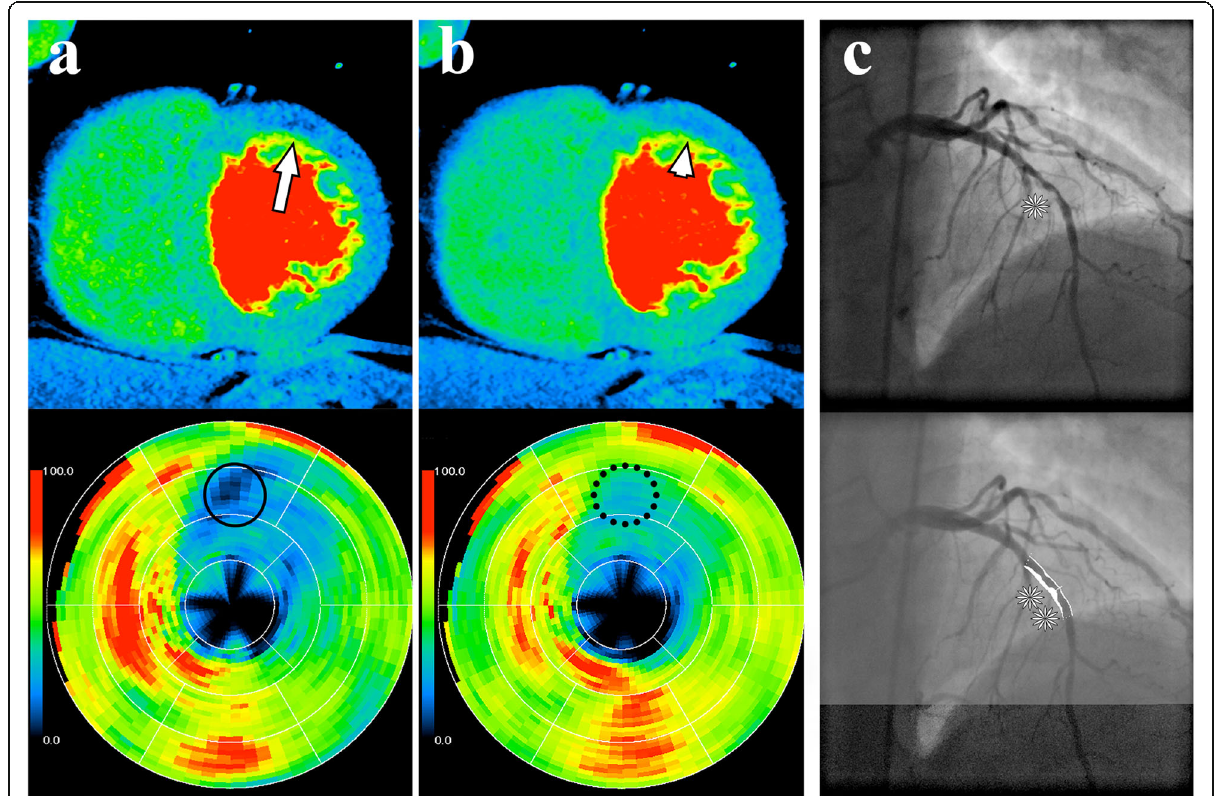
Fig. 3 HSR and two-segment MSR of stress myocardial CTP in a 55-year-old man with suspected coronary artery disease and typical angina pectoris in comparison with invasive coronary angiography. a HSR shows a moderate perfusion defect in the left anterior descending artery territory (arrow), which is also suggested by moderate hypoattenuation in the corresponding area (circle) of the polar myocardial attenuation map; CTP with HSR was considered positive. b MSR shows only very slightly reduced perfusion (arrowhead) and only weak hypoattenuation in the corresponding area (dotted circle) of the polar myocardial attenuation map; CTP with MSR was considered negative. c Invasive coronary angiography reveals visually high-grade diameter stenosis (*) of the left anterior descending artery with 61% stenosis in quantitative invasive coronary angiography (**), corresponding to a true-positive CTP with HSR ( a ) and a false-negative CTP with MSR ( b ). Contrast-enhanced CTP in mid-heart short-axis view with 8-mm slice thickness and rainbow-red colour preset using a predefined window level/window width of 200/400. CTP Computed tomography perfusion, HSR Halfscan reconstruction, MSR Multisegment